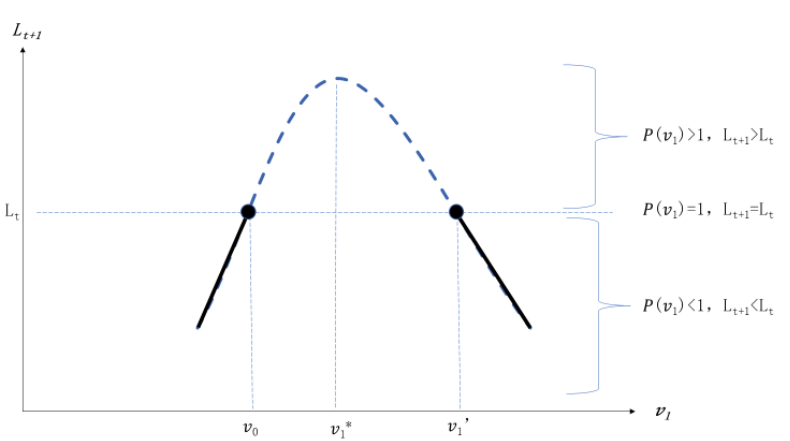
Figure 2. The initial investment of infrastructure is lower. Note: v is the proportion of public expenditure on transportation and L is the number of labors in second sector.